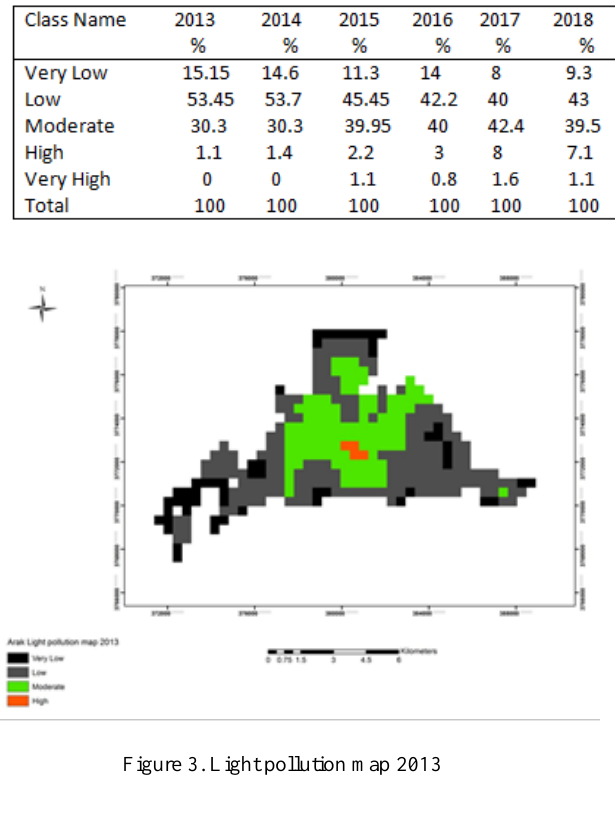
Figure 3. Light pollution map